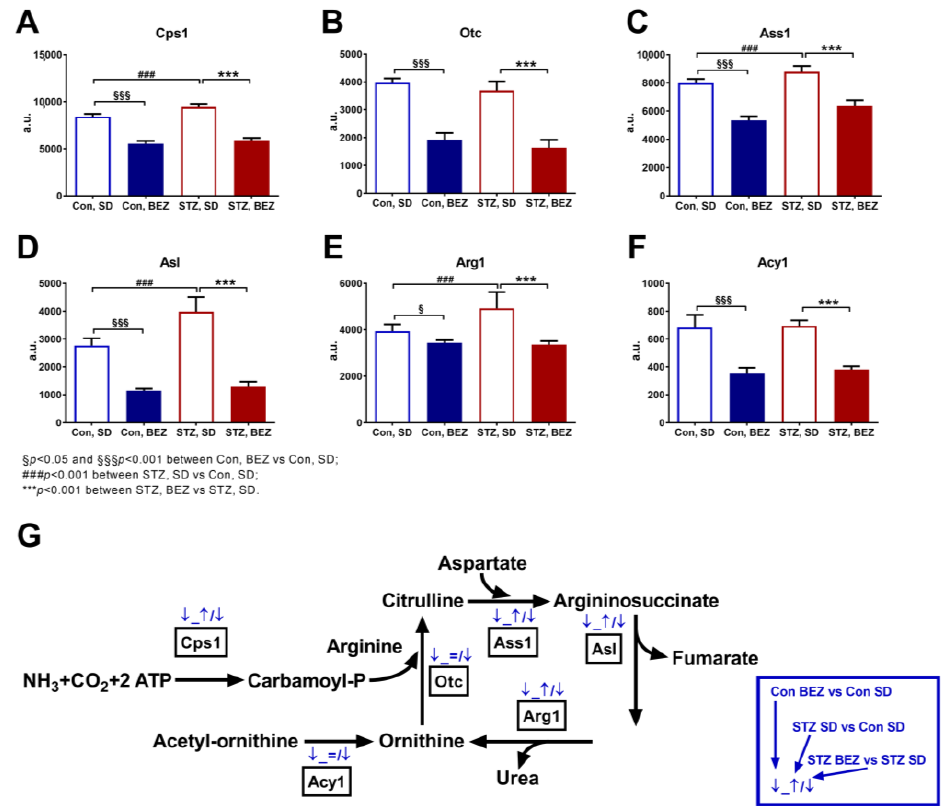
Figure 6. Transcript levels of urea cycle enzymes in liver samples of BEZ-treated STZ mice. ( A – F ) Columns represent averages ± standard deviation; n = 5 – 7. ANOVA with post hoc Holm – Sidák multiple comparison test was applied. ( G ) This figure summarizes the hepatic urea cycle genes, which were significantly differentially expressed upon BEZ treatment. The first blue arrow shows the comparison of Con, BEZ vs. Con, SD; the second blue arrow shows the comparison of STZ, SD vs. Con, SD; and the third blue arrow shows the comparison of STZ, BEZ vs. STZ, SD groups (for details see the blue rectangle on the right side). Blue “ ↑ ” or “ ↓ ” arrows show BEZ-activated or BEZ-inhibited